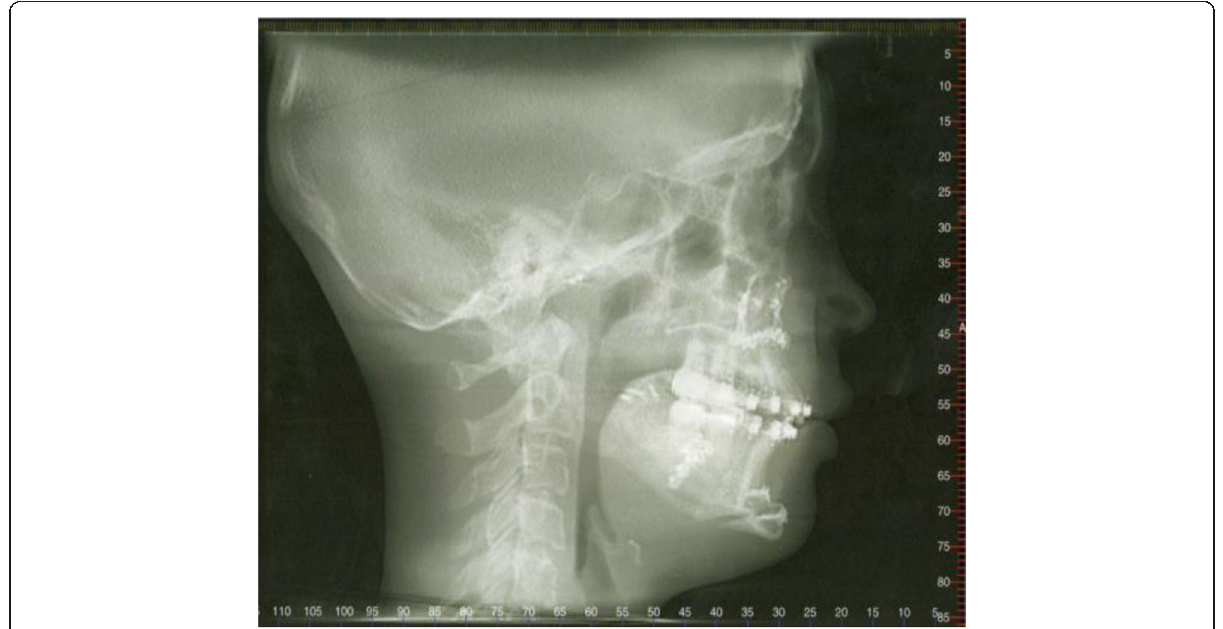
Fig. 1 Post-surgical cephalometric radiograph demonstrating the rigid fixation devices in the proximal segment of the mandible used for